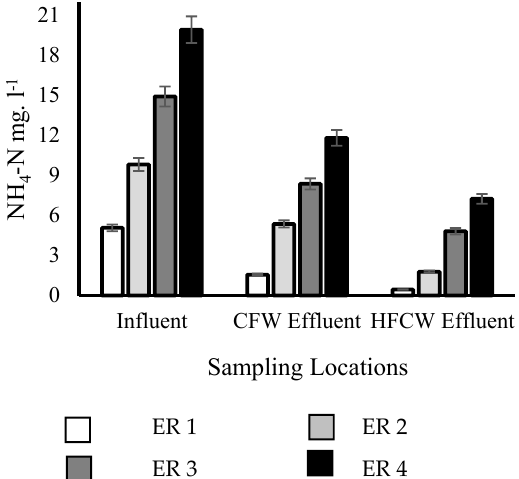
Figure 1. NH 4 –N concentration during different experimental runs in the first setup.